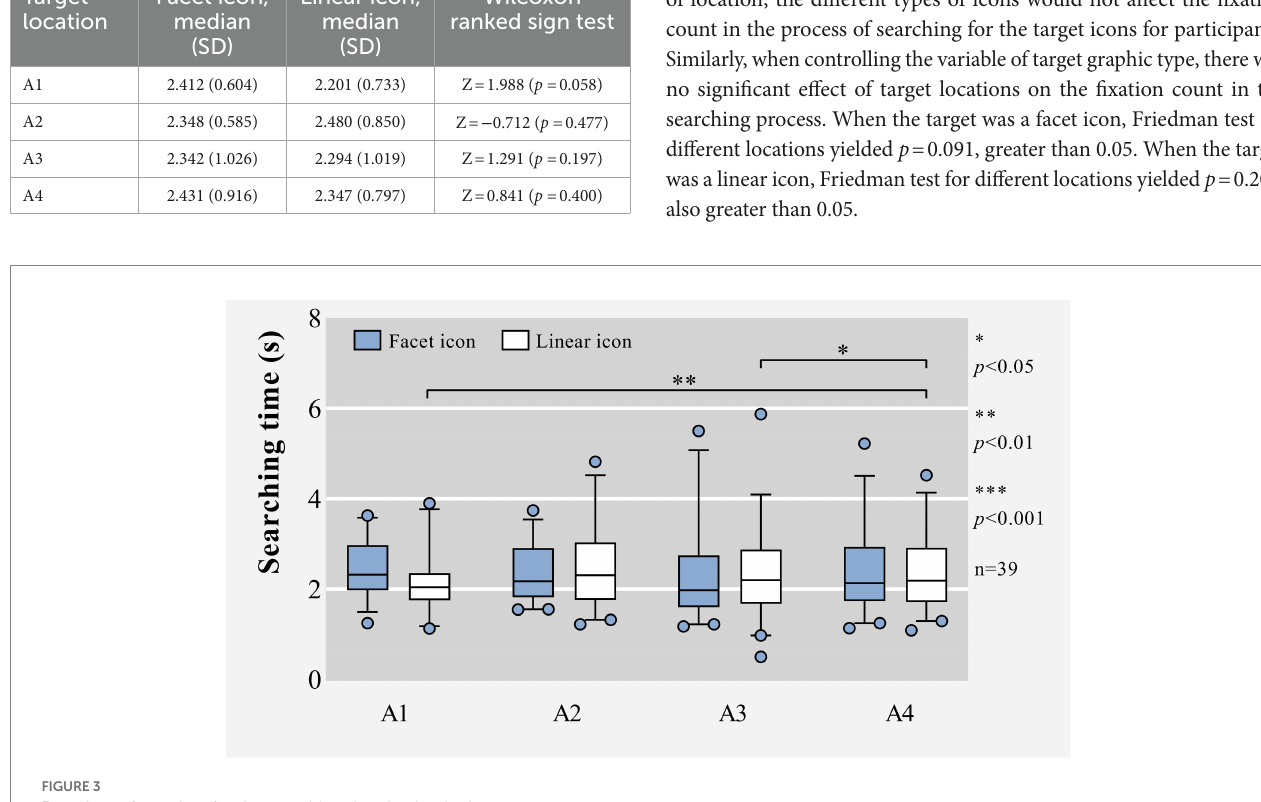
TABLE 1 Results of the searching time along the different locations. Target location